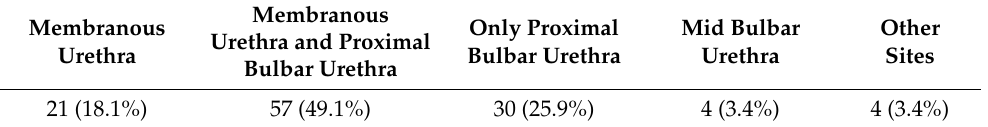
Table 1. Location of the urethral injury in 116